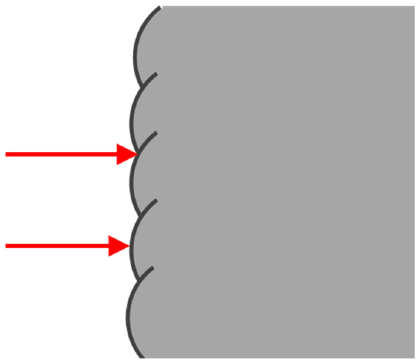
Figure 13. Possible indentation points on the side surface.